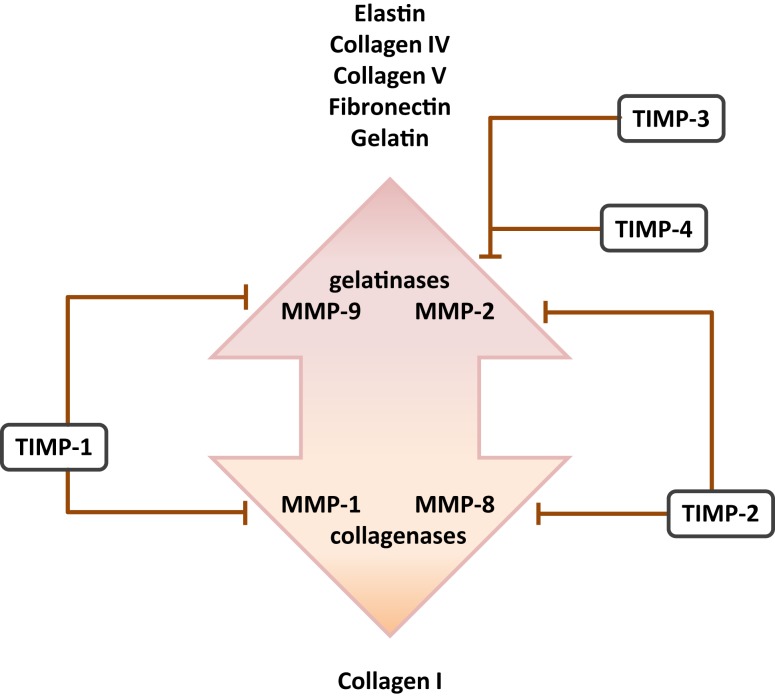
Cognate inhibitors and target substrates of matrix metalloproteinases. The target substrates of the gelatinase and collagenase members of the matrix metalloproteinase (MMP) family are indicated, together with selected target MMP substrates. Abbreviation: TIMPs, tissue inhibitor of matrix metalloproteinases.